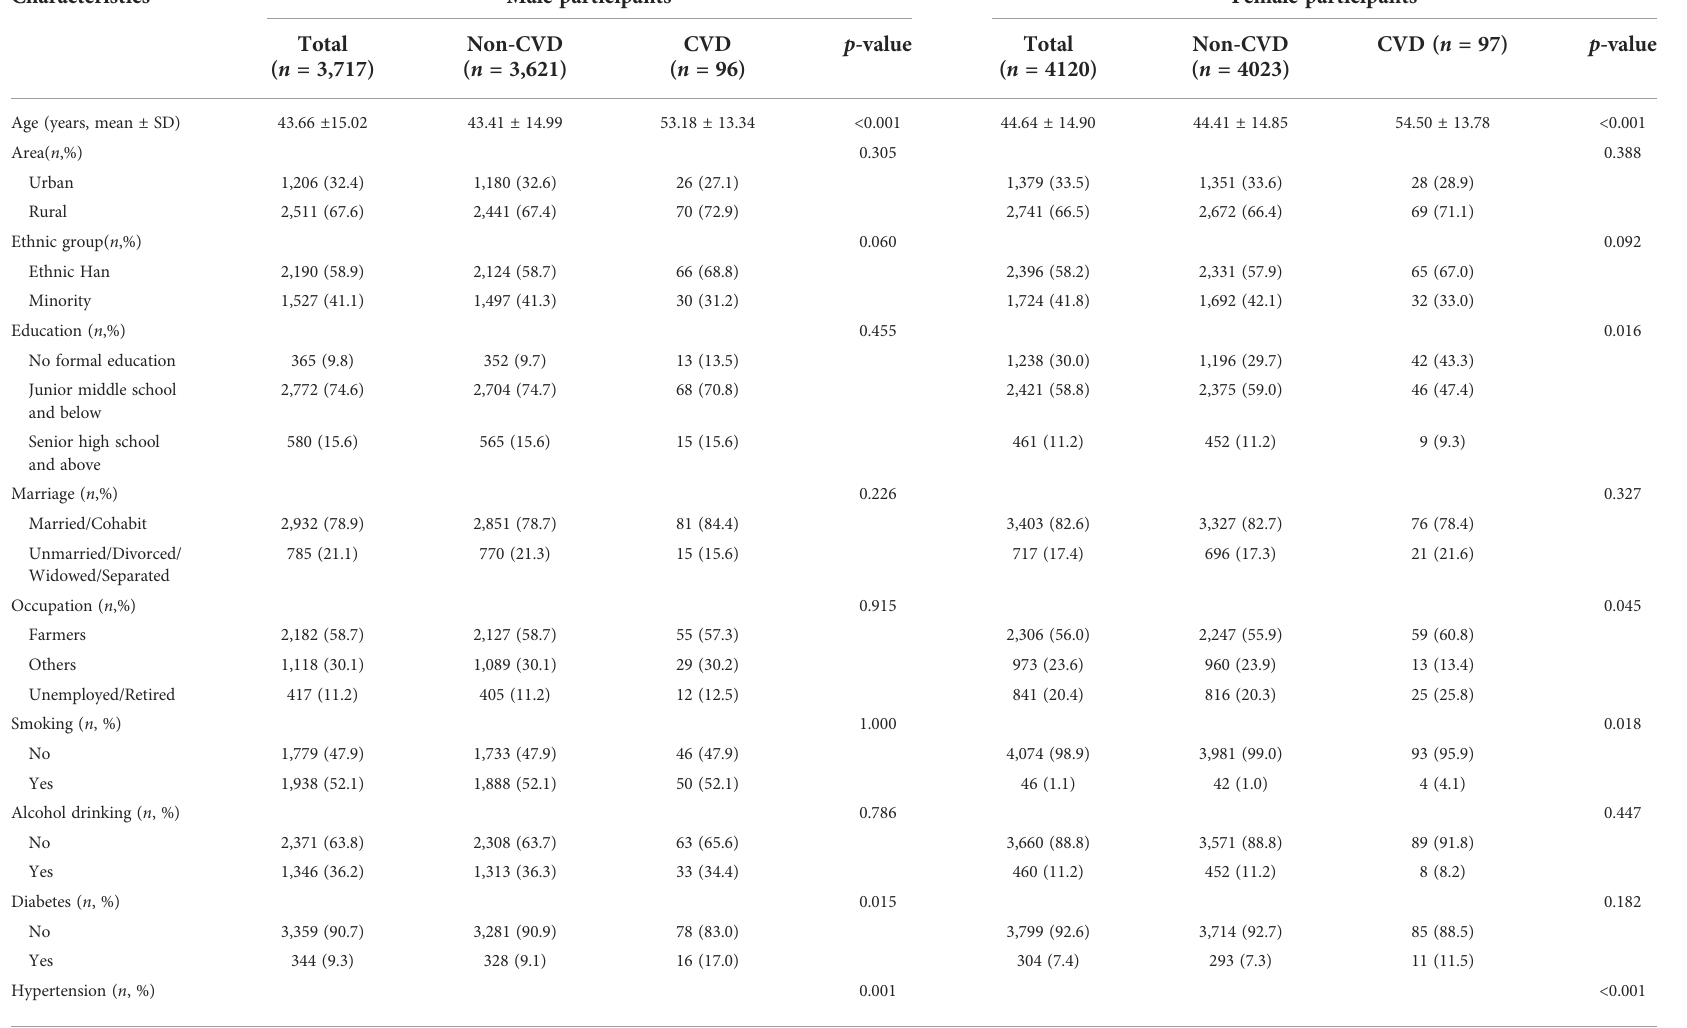
TABLE 1 Baseline characteristics for